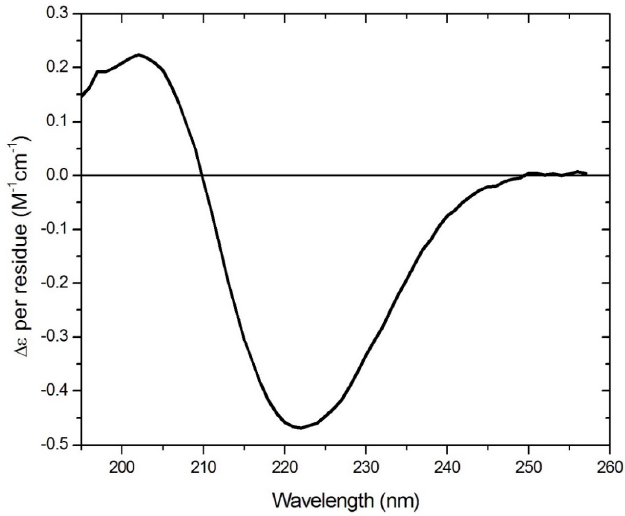
Figure 2. The far UV circular dichroism spectrum of a Lexicon cyclic peptide with the structure cyclo(sRC(C8)FsSrc(C8)fS), where L and D forms are represented by upper- and lower-case letters, respectively. The data are expressed as Molecular Circular Dichroism, or Δε per residue, using a mean molecular weight of 149. The single negative CD minimum at ~222 nm with the crossover at 210 nm is representative of the signature of a β -turn/ β -turn structure [8,9].